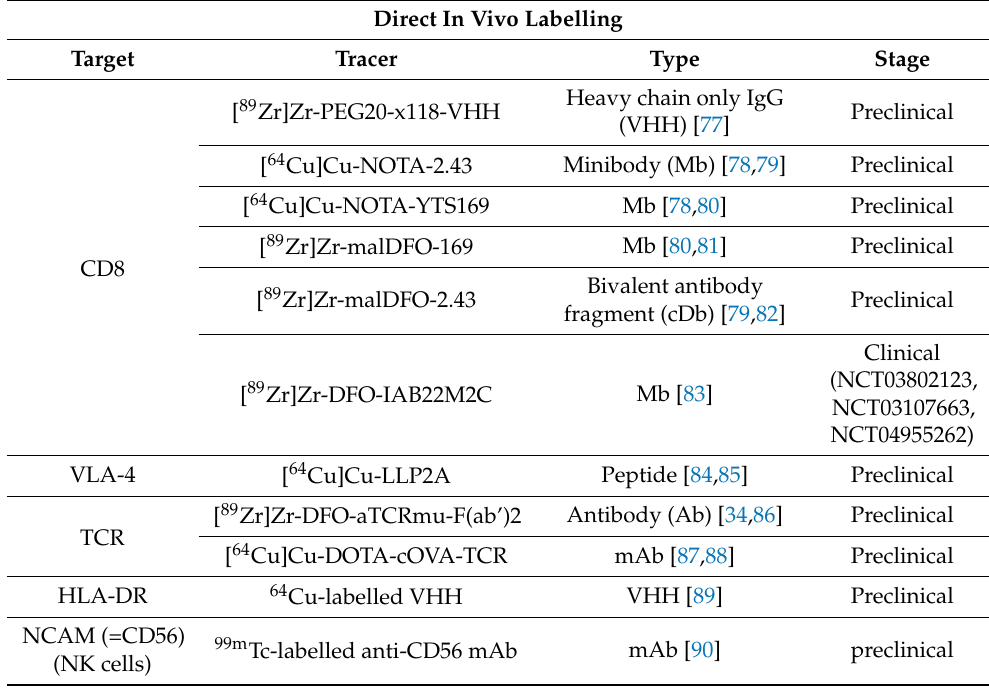
Table 3. Tracers and targets of the direct in vivo labelling method. Direct In Vivo Labelling Target Tracer